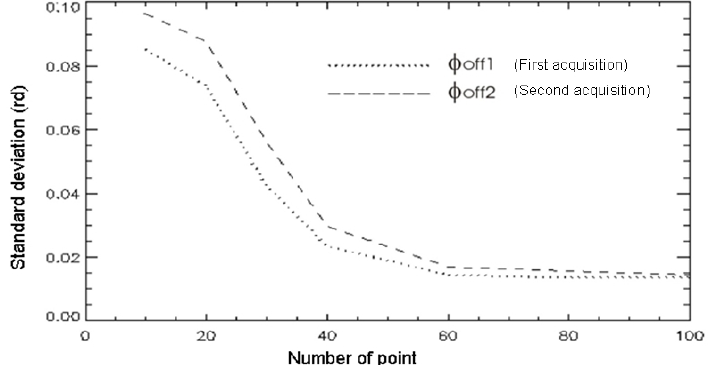
Figure 9. Standard deviation of the phase-offset values versus number of points used.